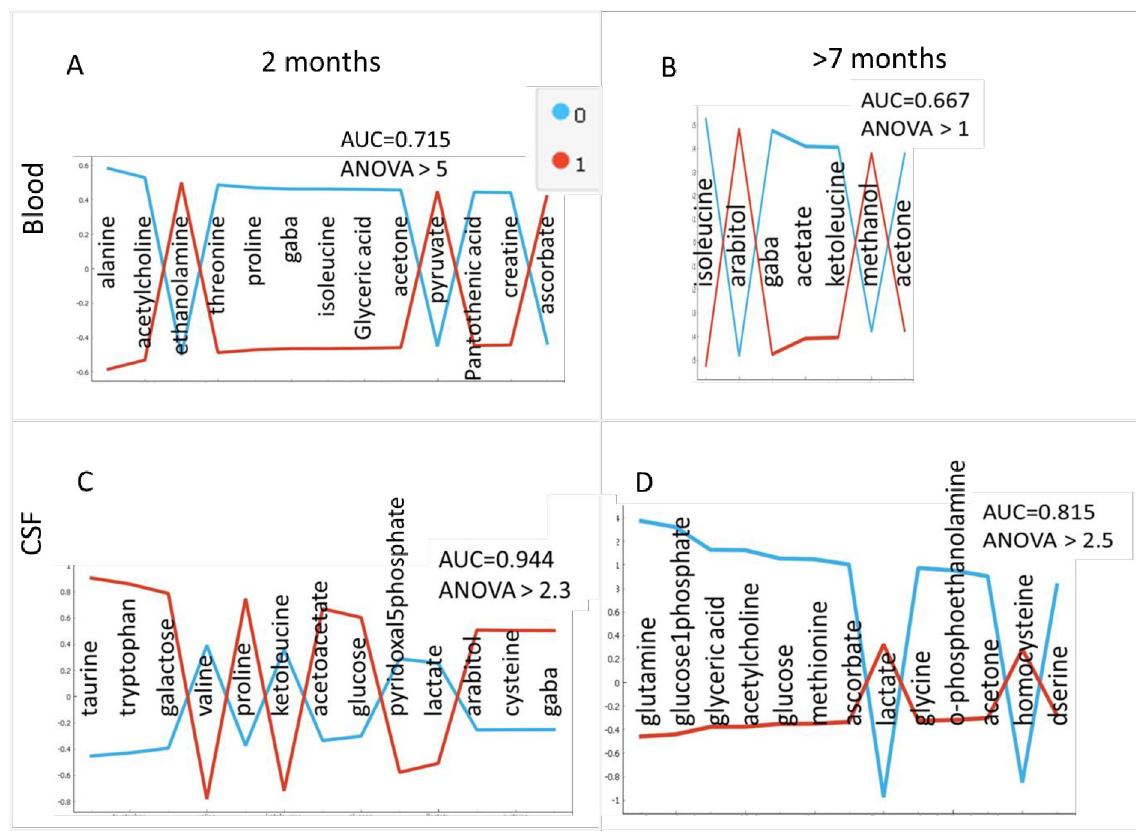
Fig 5. The most significantly differently concentrated metabolites in Blood (A and B) and CSF (C and D) between WT (blue line) and APP/ PS1 (red line) subgroups including both male and female at 2 months old (A and C) and at later time points of 7 months for male and 9 months for female mice (B and